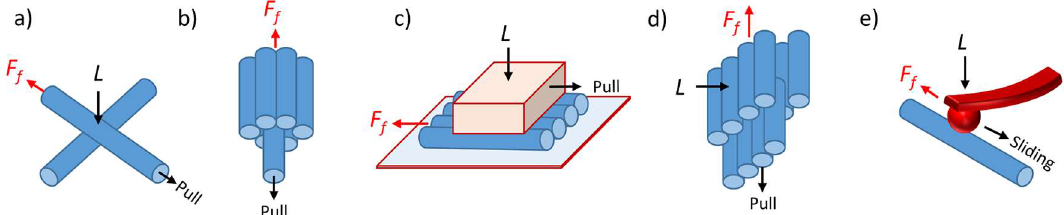
Figure 3. Different experimental procedure used for measuring fiber friction: ( a ) two crossed fibers; ( b ) single fiber withdrawing; ( c ) Sliding friction; ( d ) fiber fringe (combed nearly parallel fibers); ( e ) colloidal force microcopy.